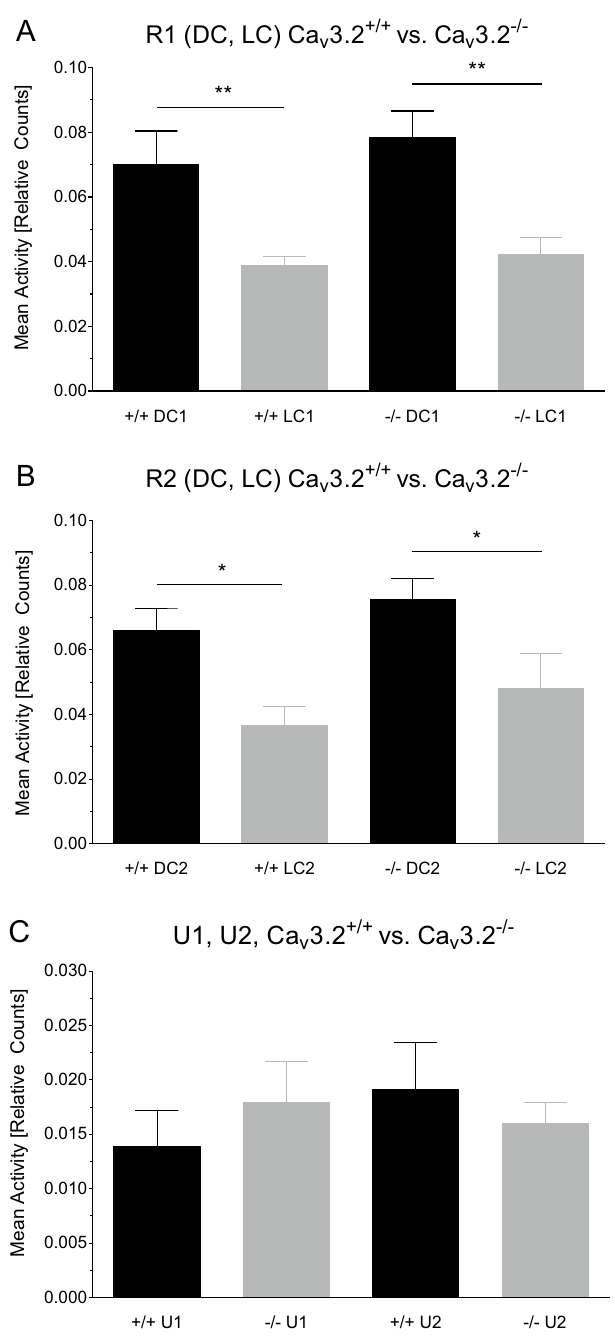
Figure 2. Activity profile in Ca v 3.2 +/+ and Ca v 3.2 −/− mice. Activity profile of Ca v 3.2 +/+ and Ca v 3.2 −/− mice during the light cycle (LC1) and dark cycle (DC1) for the first (R1, A ) and second (LC2, DC2, R2, B ) 24 h long-term recording. Both genotypes exhibit significantly increased motor activity during the DC compared to the LC in both long-term recordings (R1, R2) resembling the nocturnal behavioral characteristics of mice. No differences were observed between both genotypes, neither in R1 nor in R2. ( C ) Activity values following both urethane injections (U1, U2, 800 mg/kg i.p. each) exhibiting no significant differences within and between the genotypes. Compared to ( A ) and ( B ), mean activity values are reduced as the multi-target drug urethane does not only induce hippocampal type II theta activity but also acts as a sedative due to its antagonistic effects at glutamate receptors. Note that mean activity data represent averaged relative counts from 2 s